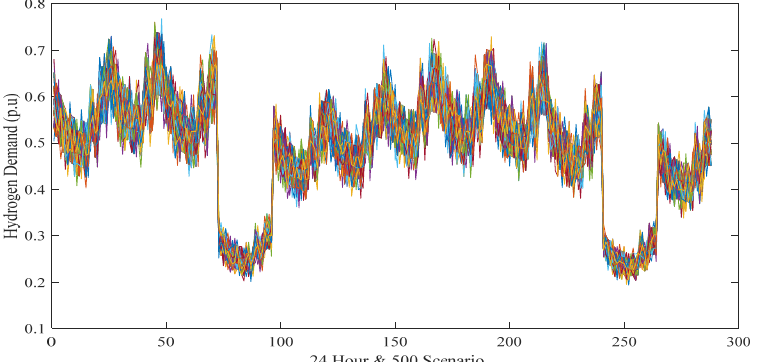
Figure 10. Hydrogen demand prediction using LSTM.